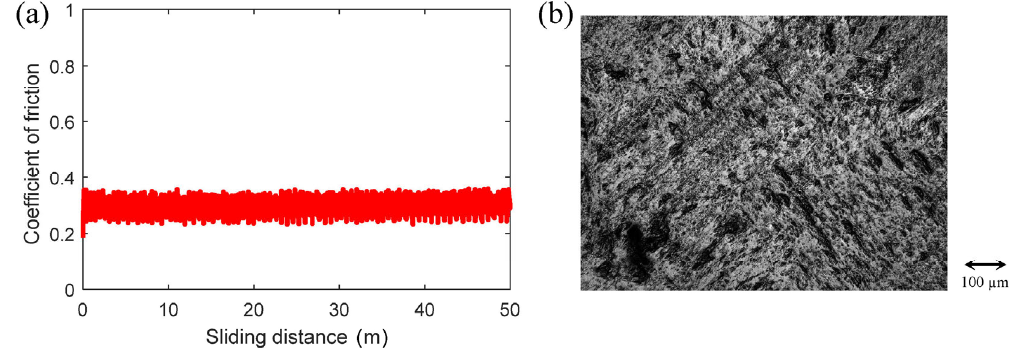
Fig. 14 (a) Coefficient of friction of “worn” composite 15 EF at a contact pressure of 0.25 MPa in contact with a clean granite counter surface, (b) counter surface after the test with the “worn” composite 15 EF on an area of 660 µm × 877